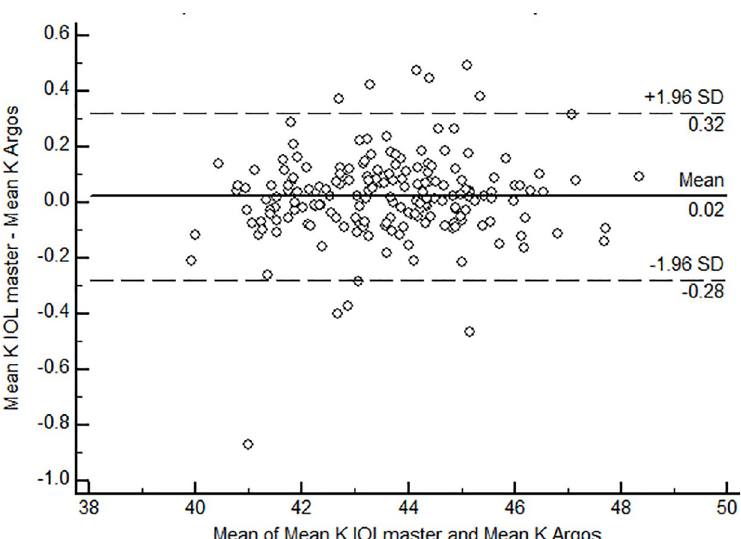
Fig 5. Bland-Altman plot of mean corneal curvature for measurements using Argos and IOL master biometers. K- Corneal curvature in